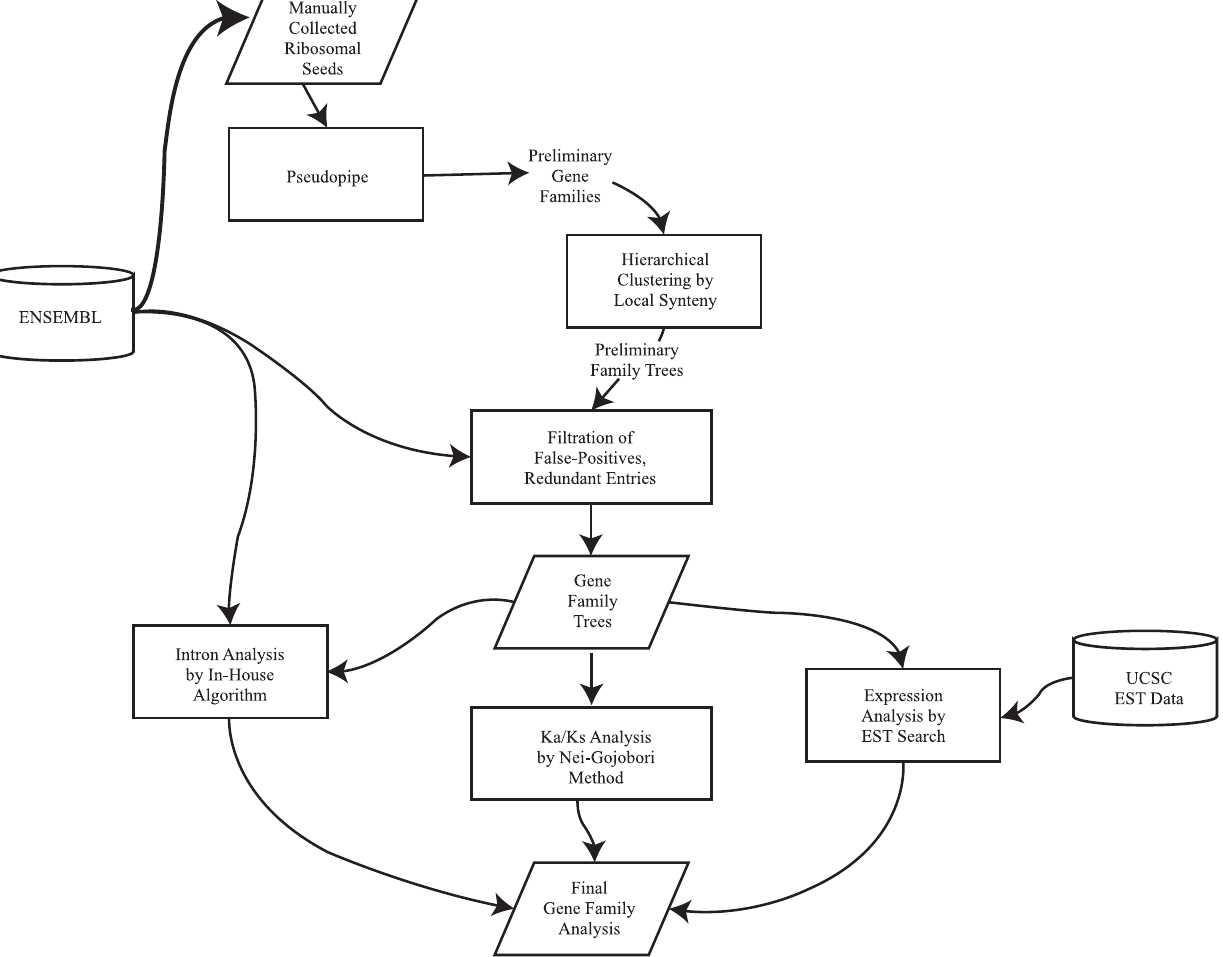
Figure 1. Pipeline for ribosomal protein family analyses. Protein sequence for all parental ribosomal proteins were collected manually from Ensembl62. These were input to tBLASTn against whole genomes to capture all putative duplicates. The resulting duplicates were processed by Pseudopipe to determine the mechanism of duplication (DNA or RNA) and the fate of the duplicate (intact or pseudogenized). We then utilized our in-house pipeline steps of hierarchical clustering by local synteny 3 in order to build our gene family trees after filtering false-positives and redundant entries. Final gene family analyses were conducted in 2 steps: 1) calculating the selective pressures on all gene duplicates using the Nei-Gojobori method against the species- and family-specific seed protein via an exon-based reconstruction, and 2) checking for expression signatures via EST analyses using the UCSC genome browser EST track for both human and mouse.